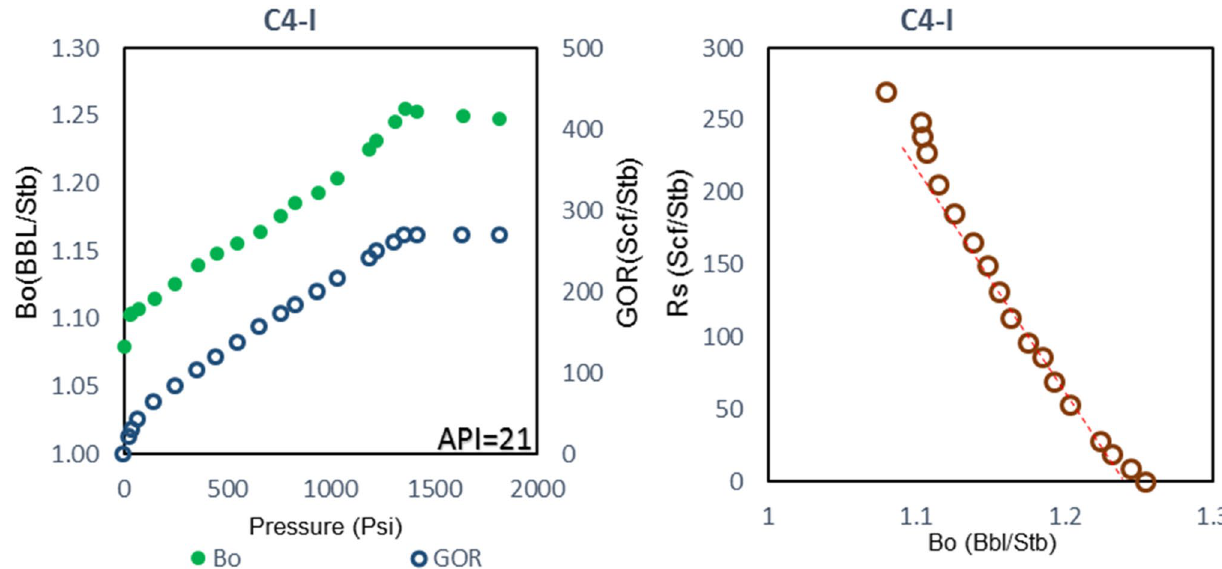
Fig. 8 Invalid trend of GOR and Bo for C4-I sample—DL